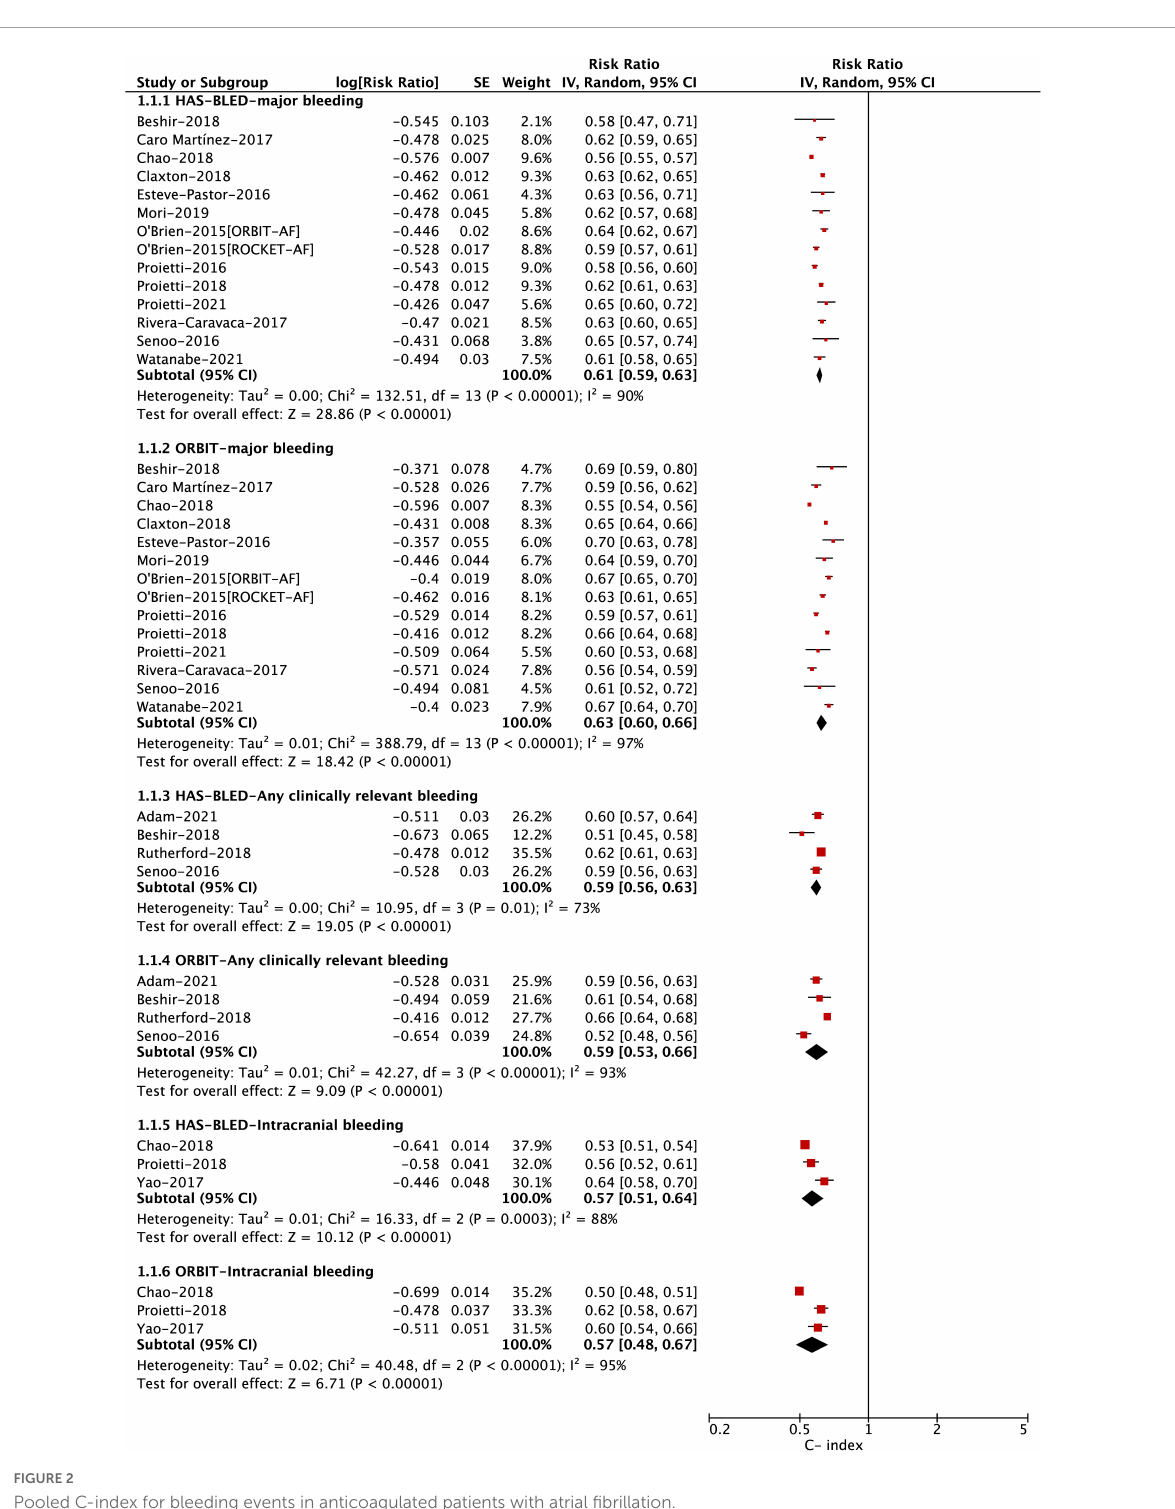
in predictive accuracy by the reclassification analysis, including the NRI and IDI values. Calibration data represented the extent to which predicted risks correspond to observed